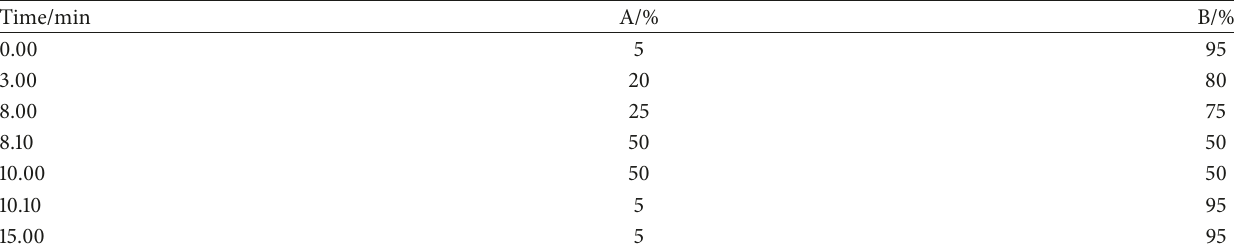
Table 1: Mobile phase gradient flow program.